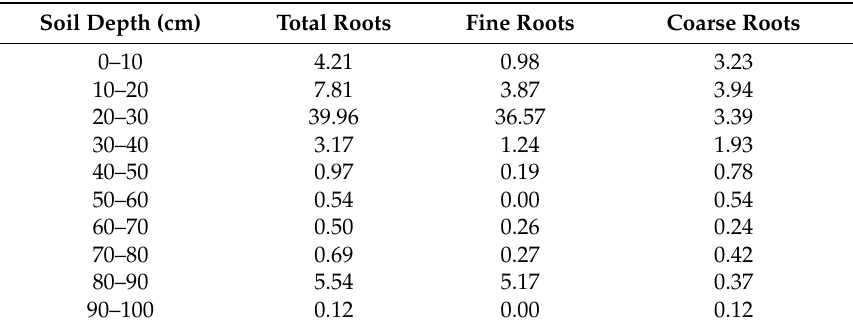
Table A1. Root biomass density along the soil profile (Unit: